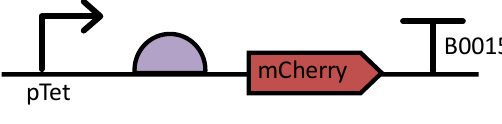
Figure 23: Examples of labels on